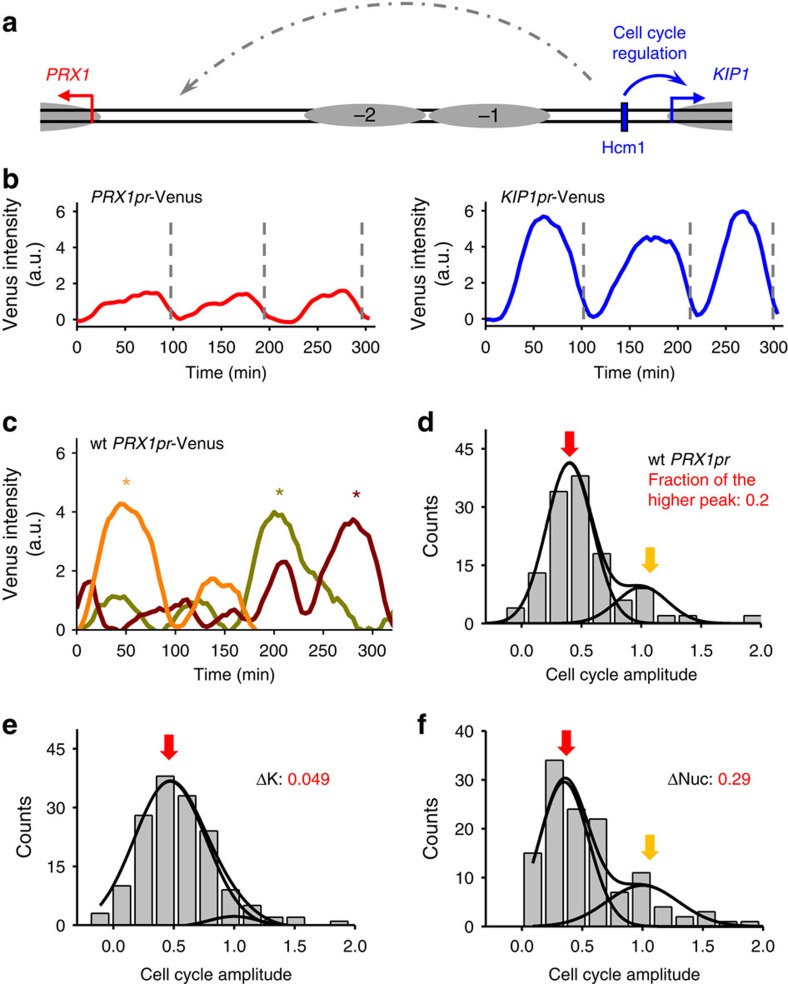
Stochastic PRX1 cell cycle activation from the KIP1 UAS.(a) Genomic structure of PRX1–KIP1 divergent promoter. Blue rectangles, putative Hcm1 binding sites and grey ovals, nucleosomes. (b) Typical traces of Venus expression driven by WT PRX1–KIPpr from the PRX1 orientation (left) or KIP1 orientation (right) during vegetative growth. Each trace represents the Venus intensity as a function of time in a single yeast cell over multiple cell cycles. The vertical dash lines indicate the cell division time. In most cells, KIP1pr, but not PRX1pr, shows strong cell cycle-regulated activity. (c) Selected traces of PRX1pr-Venus with high cell cycle oscillation (marked by ‘*'). These traces occur in a small fraction of cells. (d-f) Histograms of the cell cycle amplitude of Venus driven by WT or mutant PRX1 promoter. ΔK, deletion of the KIP1 side of the promoter including nucleosome −1; ΔNuc, deletion of the nucleosomal sequences in the middle of the promoter. The WT PRX1 promoter and ΔNuc showed bimodal cell cycle amplitude, and the higher peak is eliminated in the ΔK promoter. Number of cell cycles: WT, 129; ΔK, 155; ΔNuc, 125.